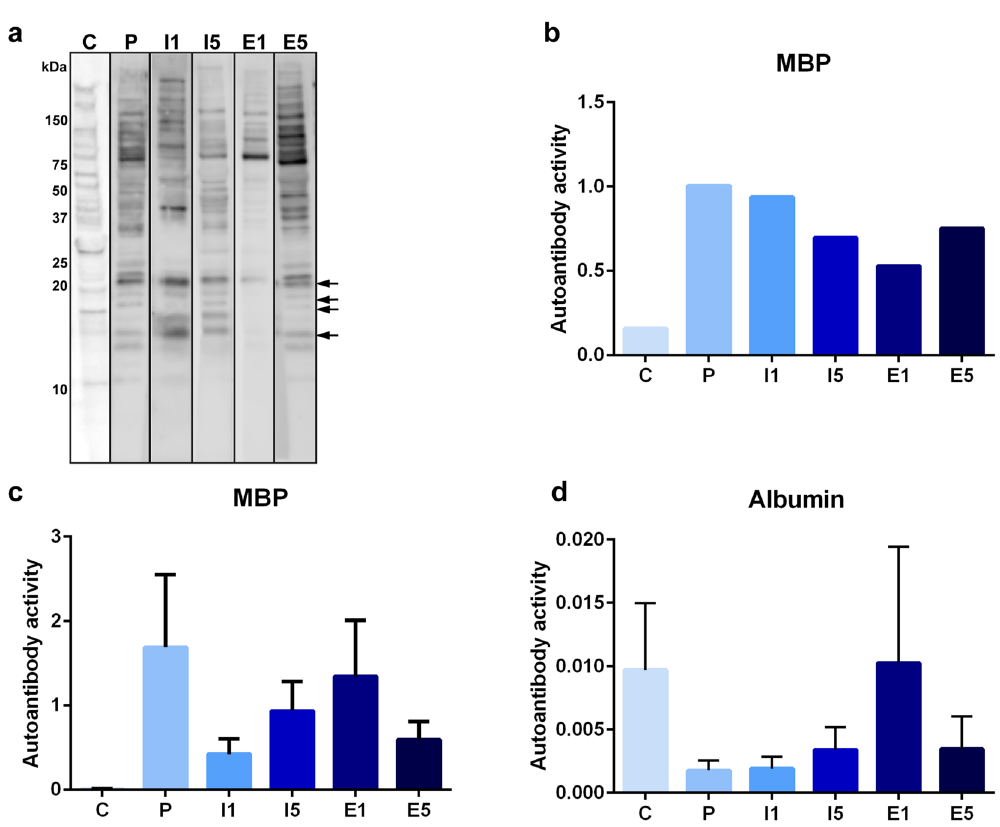
Figure 2. Western blots showing expression of brain antigens recognized by serum-derived antibodies; control (C), placebo (P), IFN- β on day 1 (I1), IFN- β on day 5 (I5), etomoxir on day 1 (E1) and etomoxir on day 5 (E5). Protein marker positions are indicated to the left (kDa). MBP bands are marked with arrows. Serum samples are derived from the same experiment. Each blot represents a sample from the different treatment groups, and blots were cropped and processed in parallel ( a ). Indirect ELISA showing the concentration ( µ g/ml) of serum-derived autoantibodies towards MBP in the presented blots ( b ). Indirect ELISA showing the concentration ( µ g/ml) of serum-derived autoantibodies towards MBP ( c ) and albumin ( d ) in all the animals. Data are presented as the mean ±